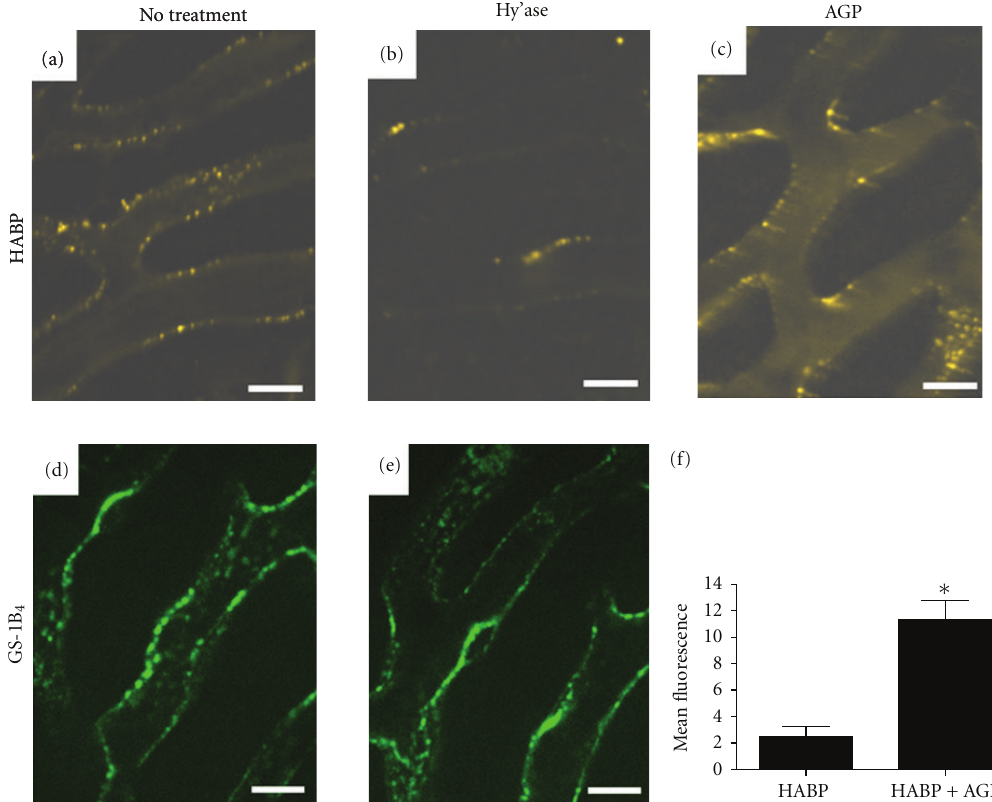
Figure 6: Either systemic hyaluronidase treatment or AGP administration reduces HABP binding to the vessel wall of mouse liver sinusoids in vivo . Mice were treated with hyaluronidase (Hy’ase; (b) and (e)) or without hyaluronidase (no treatment; (a) and (d)) after injection of either fluorescent HABP complex or fluorescent GS-1B 4 and visualization of liver sinusoids by confocal intravital microscopy. (c) Is an image of an experiment in which AGP intravenous injection was substituted for hyaluronidase. (f) (Mean of n = 3 ± SD) quantifies the intrasinusoidal HABP fluorescence in the experiment shown in (c) and in three additional replicates; each replicate is the mean of four intravascular samples within microscopic fields similar to that seen in (c); ∗ signifies P < 0 . 05 by unpaired t -test, Welch